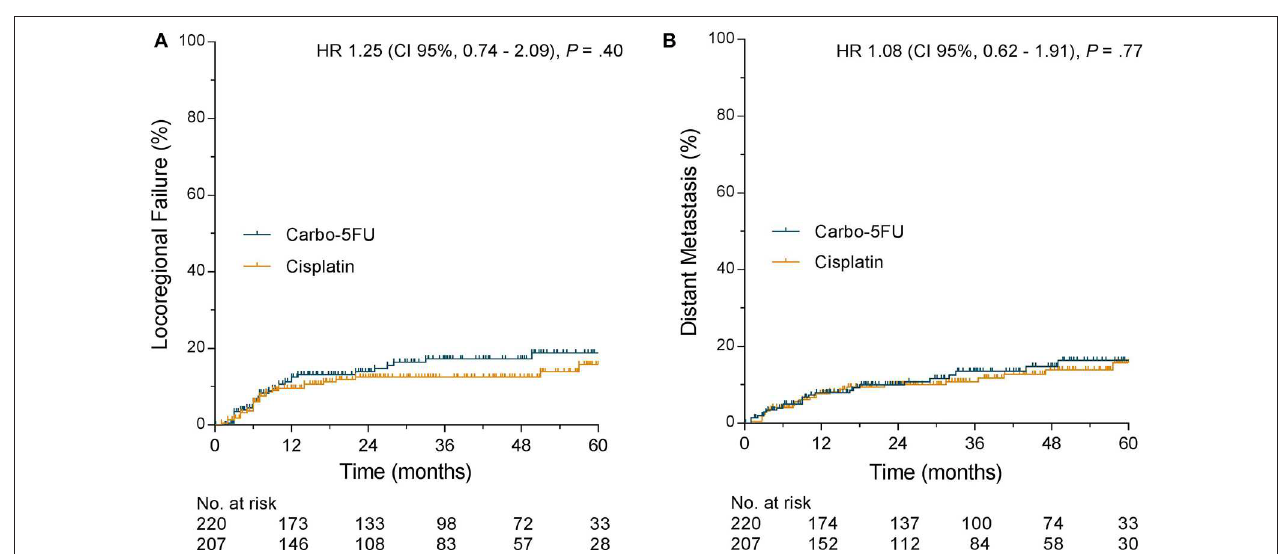
FIGURE 2 | (A) Locoregional failure stratified by chemotherapy regimen. (B) Distant metastasis-free interval stratified by chemotherapy regimen.